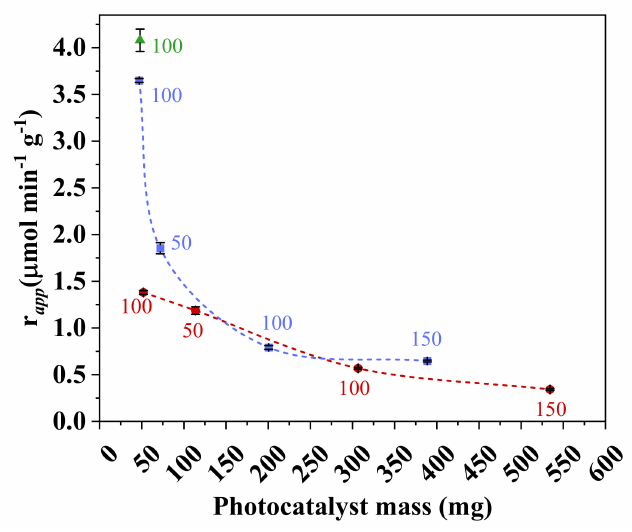
Figure 10. Effect of photocatalyst mass on the apparent reaction rate ( r app ) in ZnO composite samples with PVP ( (cid:4) ), without PVP ( • ), and with APTES ( (cid:78) ). Conditions: irradiation intensity = 245.5 W m − 2 ; C VOC,feed = 78.8 ppm; Q feed = 150 cm 3 min − 1